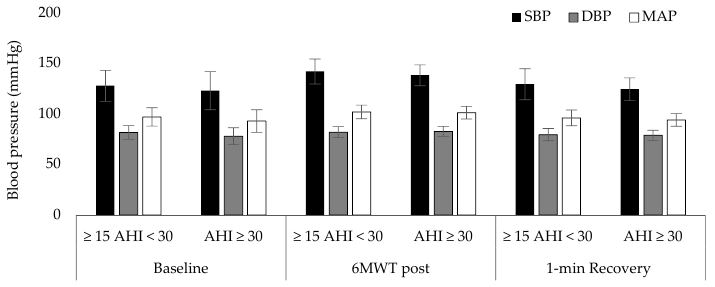
Figure 6. Blood pressure [(Systolic blood pressure (SBP), diastolic blood pressure (DBP), and mean arterial pressure (MAP)] alteration during 6 min walk test (6MWT).